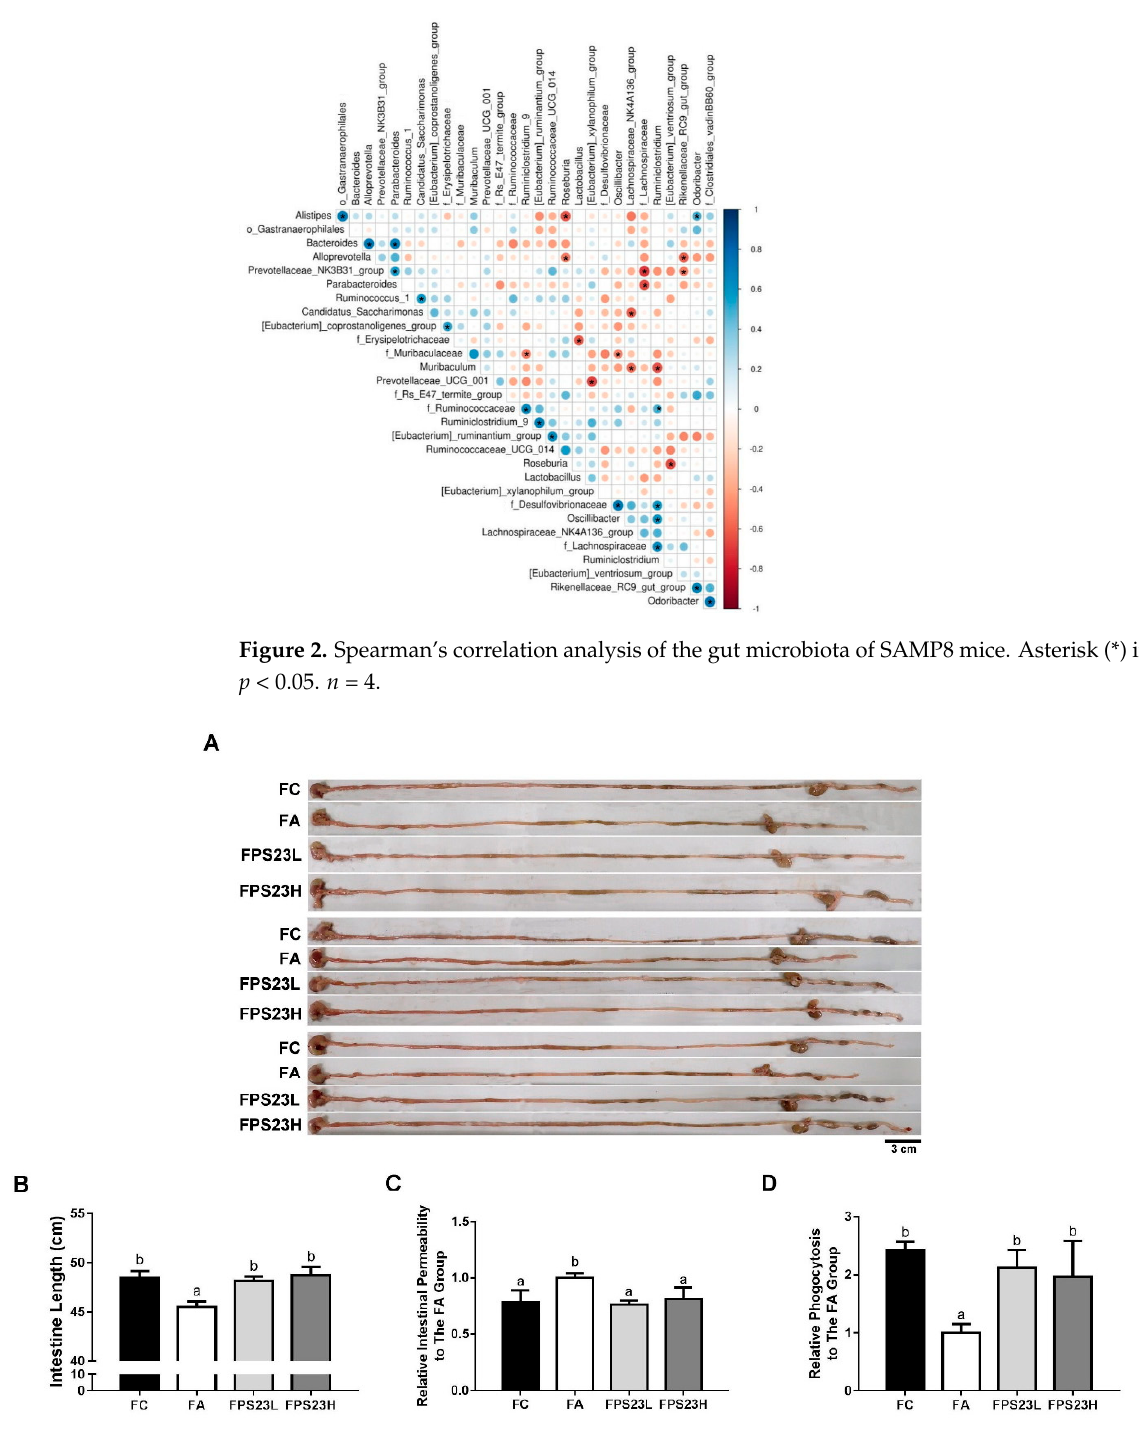
Figure 3. Intestinal function. ( A ) Representative experiments of intestine length, ( B ) intestinal length, ( C ) intestinal permeability, and ( D ) phagocytosis in the SAMP8 mice. Different superscript letters (a, b, c) indicate significant differences in one-way ANOVA by Tukey’s honestly significant difference (HSD) post hoc test ( p < 0.05). n = 4. Scale bar = 3 cm.